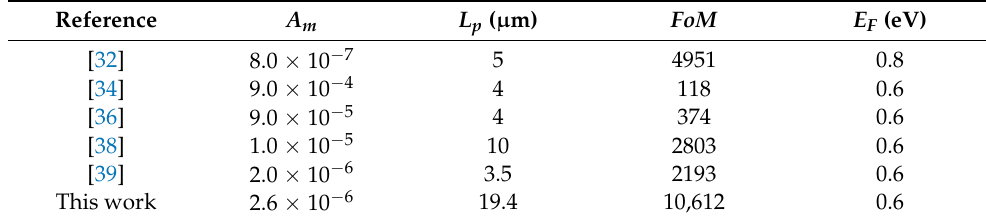
Table 1. Comparisons of the modal properties of A m , L p , and FoM